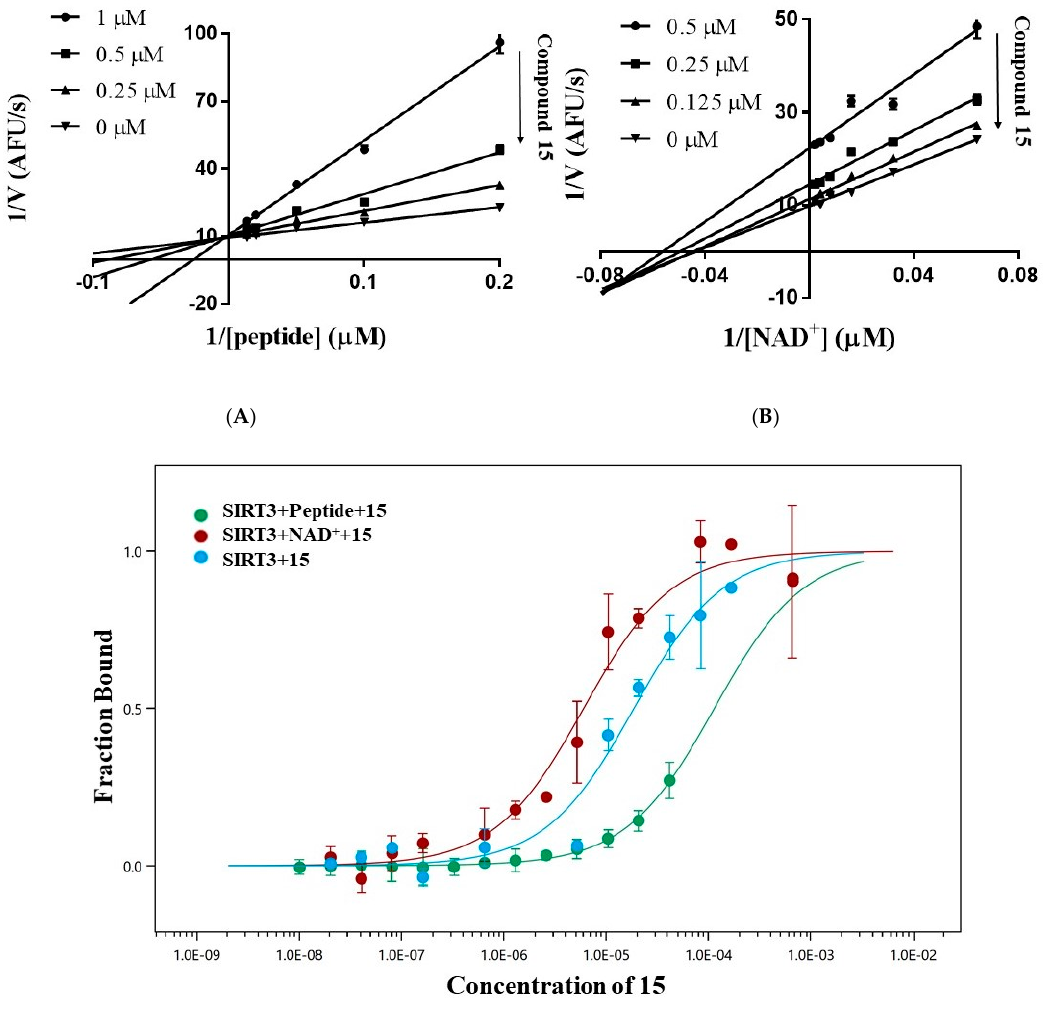
Figure 5. Inhibition pattern of compound 15 . ( A ) Lineweaver–Burk plot of the velocity of deacetylation versus the concentration of the acetyl peptide (5.0–100.0 µ M) in absence or presence of 0.25 µ M, 0.5 µ M or 1.0 µ M of 15 shows that 15 is a competitive inhibitor for the acetyl peptide. ( B ) Lineweaver–Burk plot of the velocity of deacetylation versus the concentration of NAD + (15.625–500.0 µ M) in the absence or presence of 0.125 µ M, 0.25 µ M, or 0.5 µ M of 15 shows that 15 is a mixed-type inhibitor for NAD + . ( C ) Microscale thermophoresis to determine the dissociation constant K d of 15 with SIRT3 in the absence or presence of 5 mM NAD + or 50 µ M acetyl peptide.